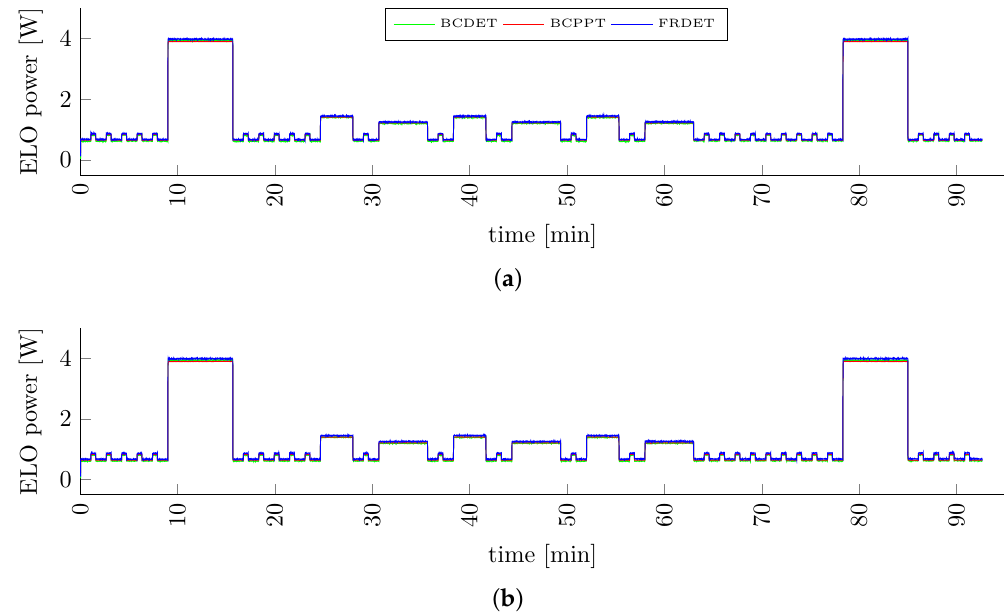
Figure 13. ELO dissipated power for initial OCV of: ( a ) 4.0V; ( b ) 3.5V.